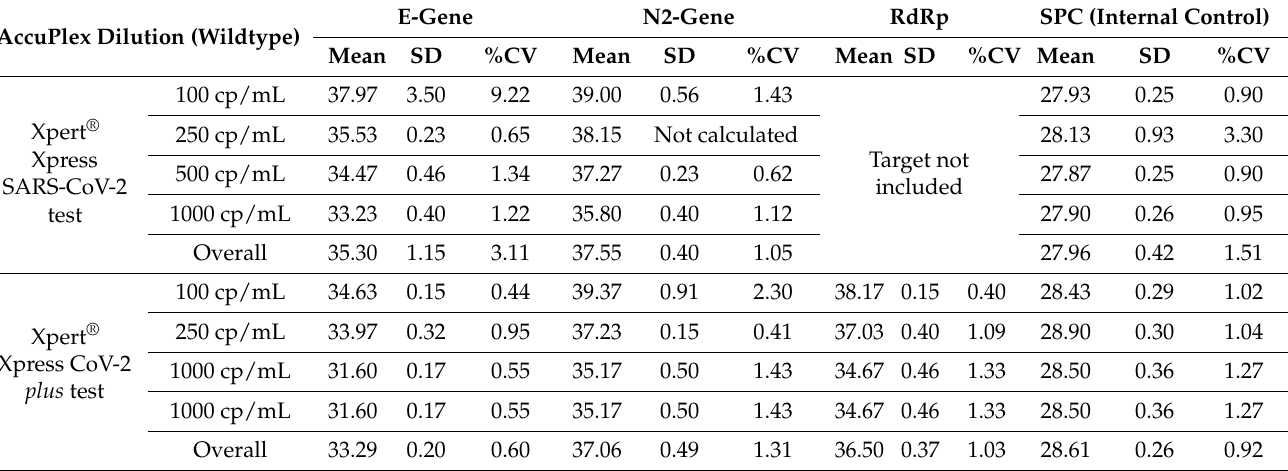
Table 3. Precision of the Xpert ® Xpress SARS-CoV-2 and Xpert ® Xpress CoV-2 plus